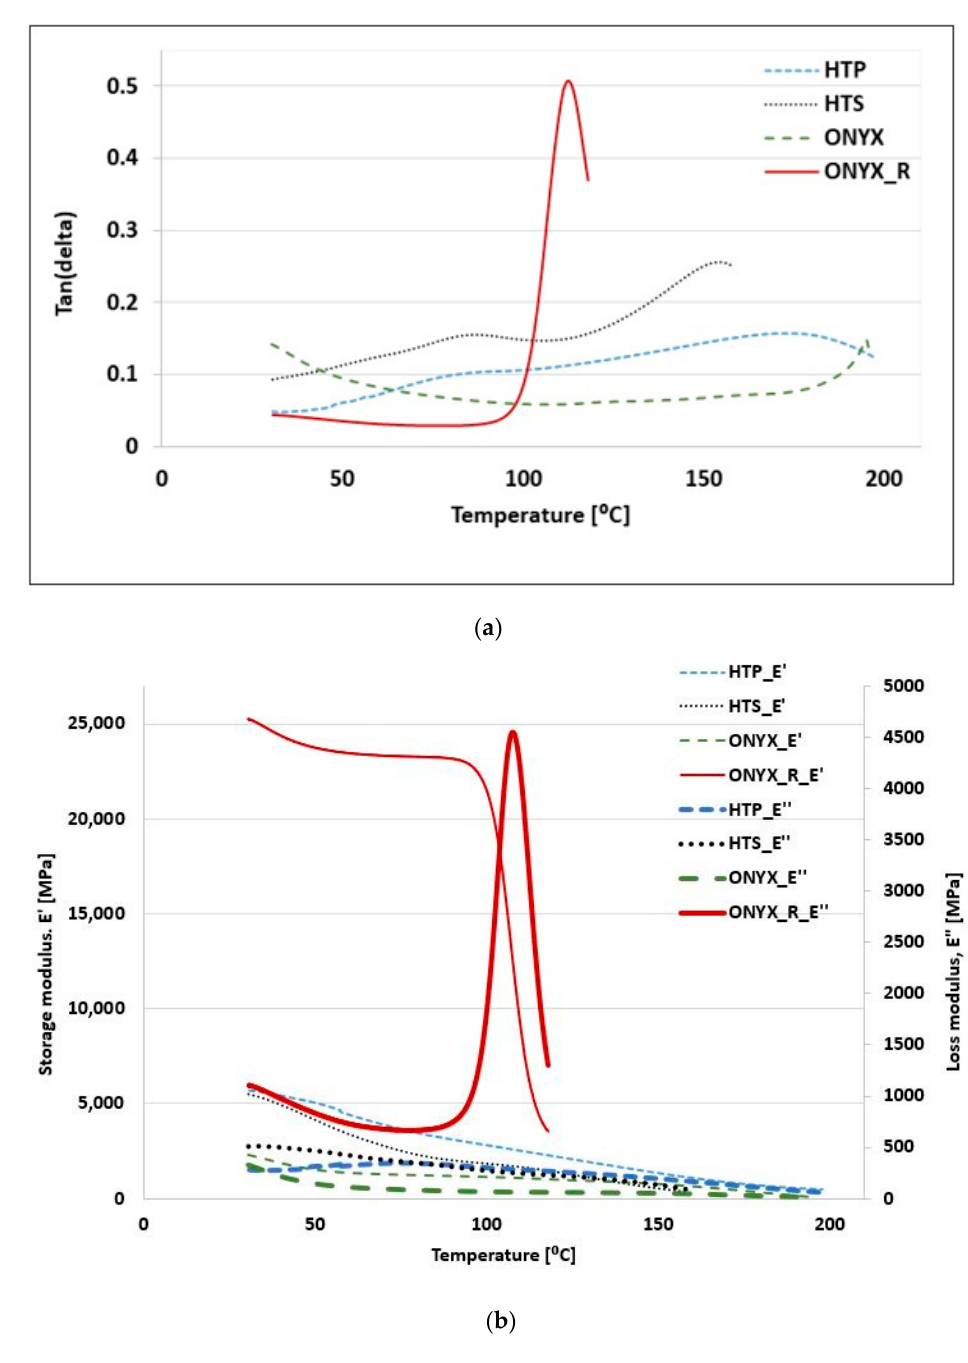
Figure 7. DMA measurements results: ( a ) Tan δ —Temperature curves; ( b ) Storage and Loss flexural modulus—Temperature curves.